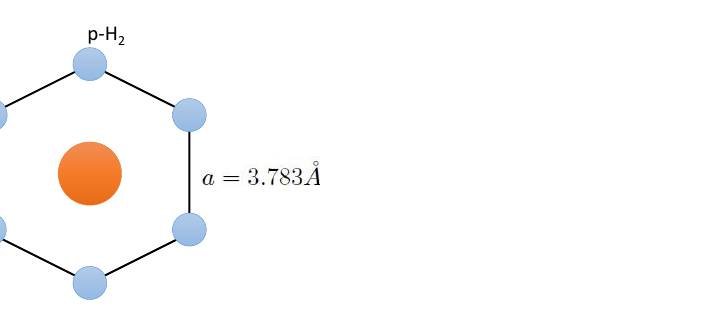
Figure 6. The alkali atom at the center of the hexagonal structure of the solid p-H 2 matrix. The alkali atom (orange circle) is assumed to substitute one of the molecules of the solid matrix of p-H 2 (blue